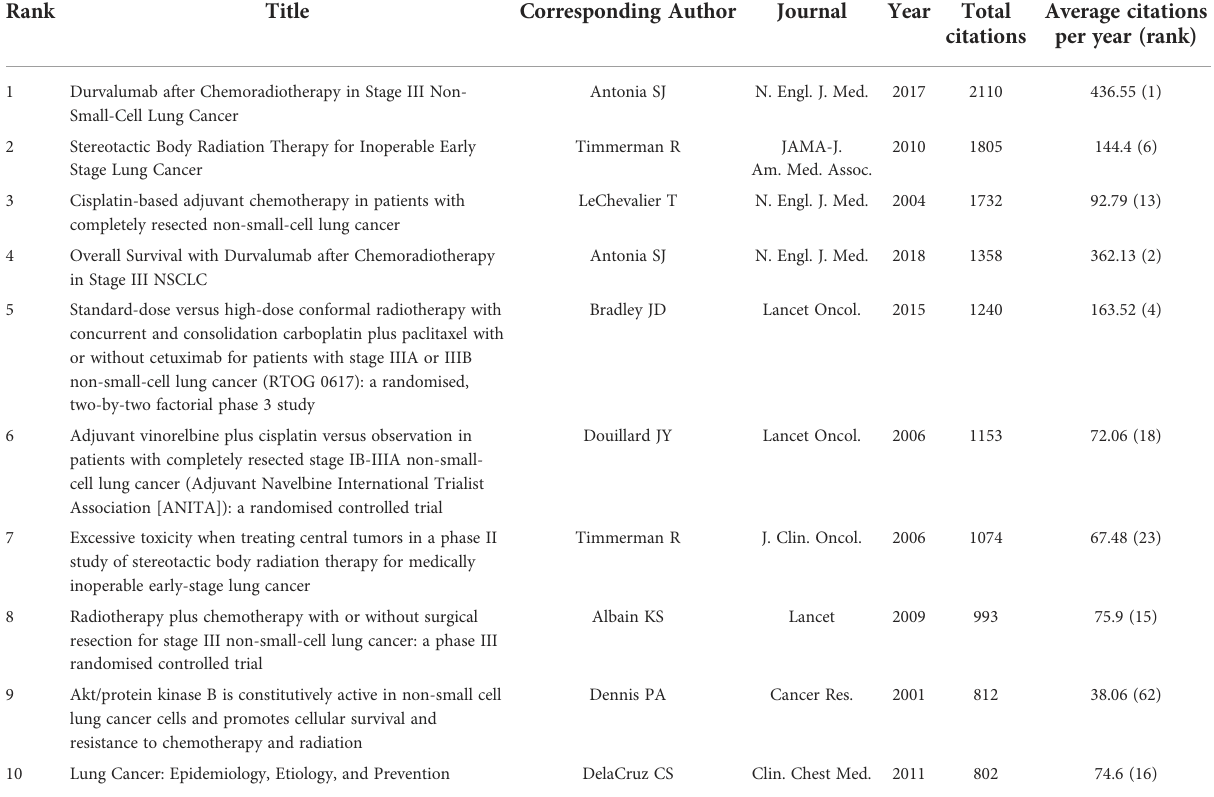
TABLE 1 The 10 most cited papers in lung cancer radiotherapy from 2000 to 2022 a